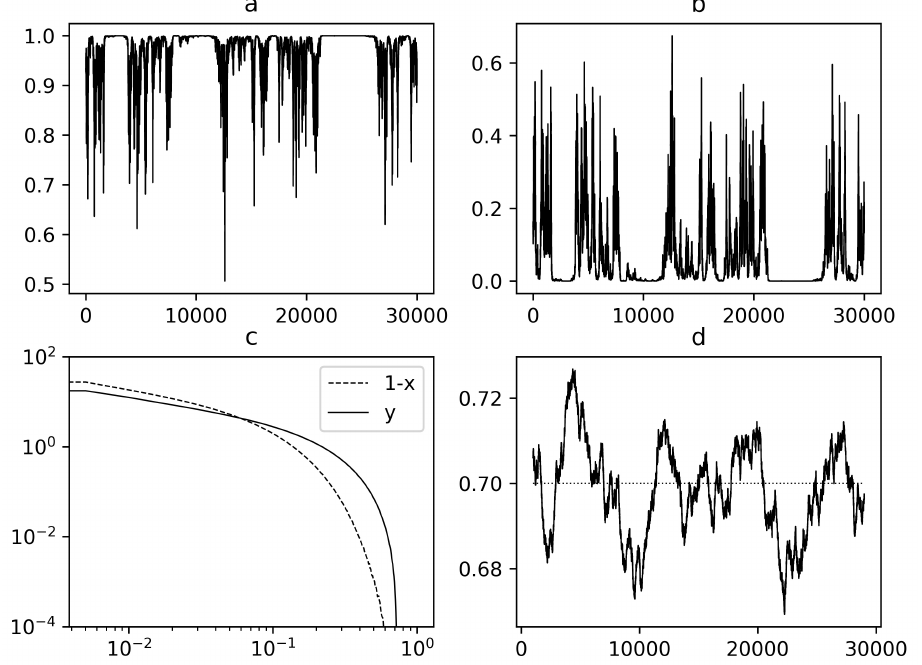
Figure 5. Stochastic K 0 with α = 1.4. Time series of x (Panel a ), y (Panel b ) and of the running mean of the random variable ρ controlling K 0 , computed on a window with width τ = 2000—the dotted line is the mean value of ρ (Panel d ). The probability distributions of the maxima of 1 − x and y are shown in (Panel c